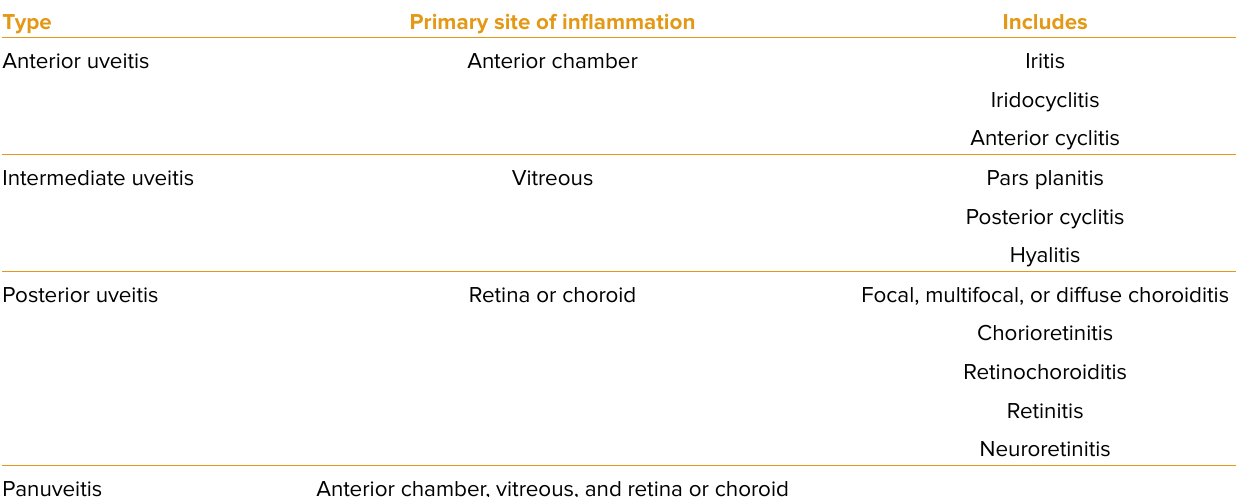
Iridocyclitis Anterior cyclitis Posterior cyclitis Hyalitis Chorioretinitis Retinochoroiditis Retinitis